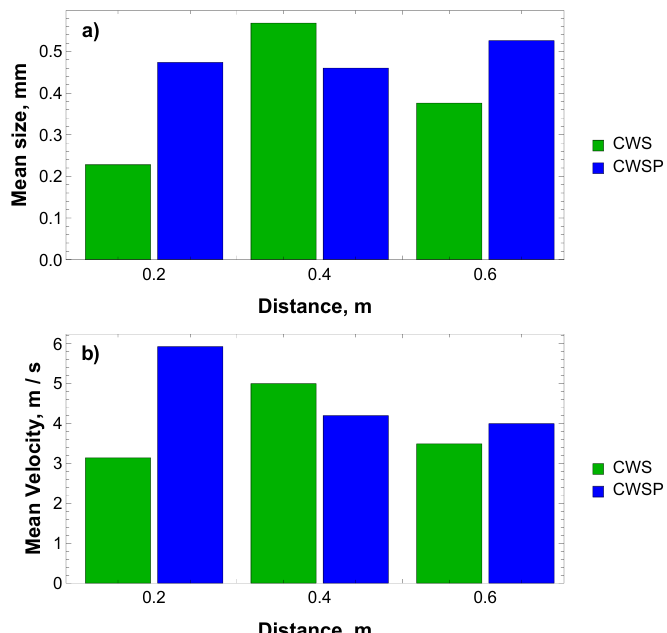
Figure 4. The mean values for sizes ( a ) and velocities ( b ) of the aerosol particles at different distances from the